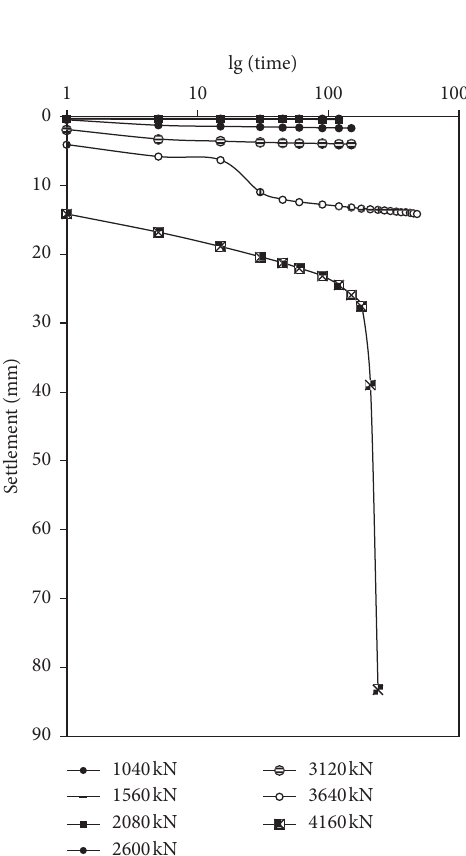
Figure 13: Q-s curve of P60.